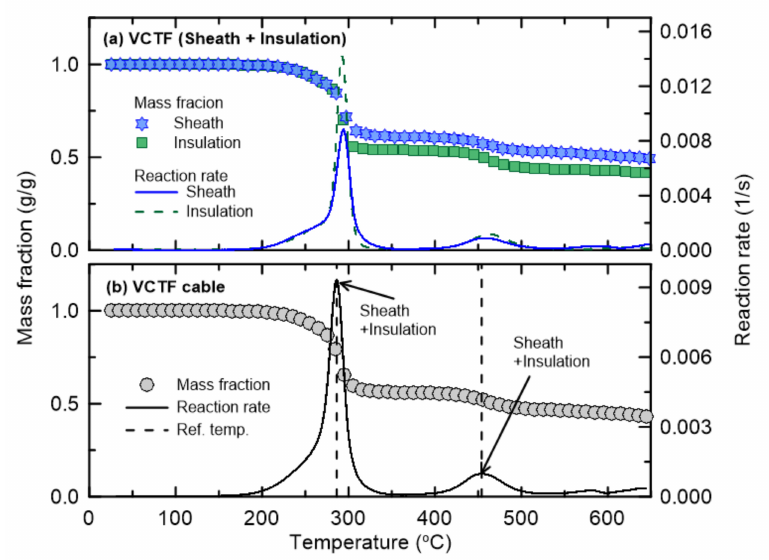
Figure 7. Comparison of mass fraction and reaction rate as a function of temperature for VCTF